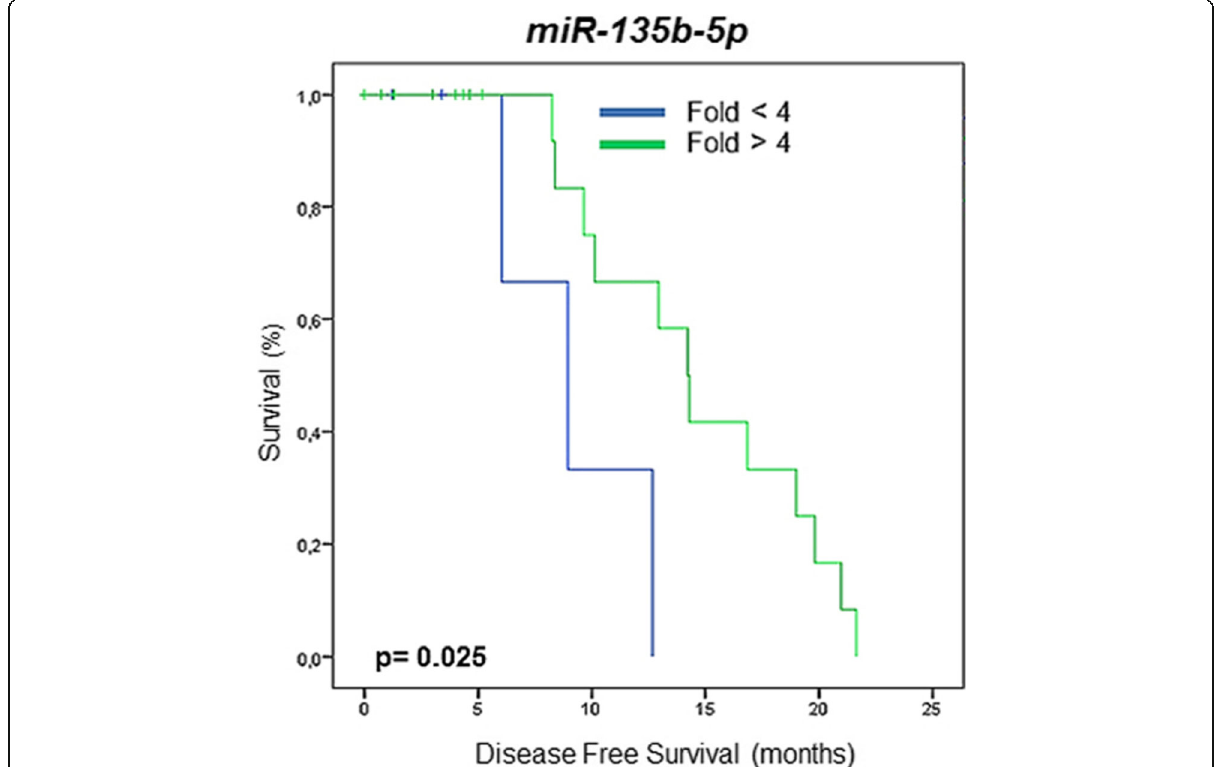
Fig. 3 Survival rates associated with miR-135b-5p expression. A Kaplan-Meier survival analysis shows DFS rates that are associated with positive expression values of miR-135b-5p . Data associated with less than a 4-fold change are shown in blue, while data associated with greater than a 4-fold change are shown in